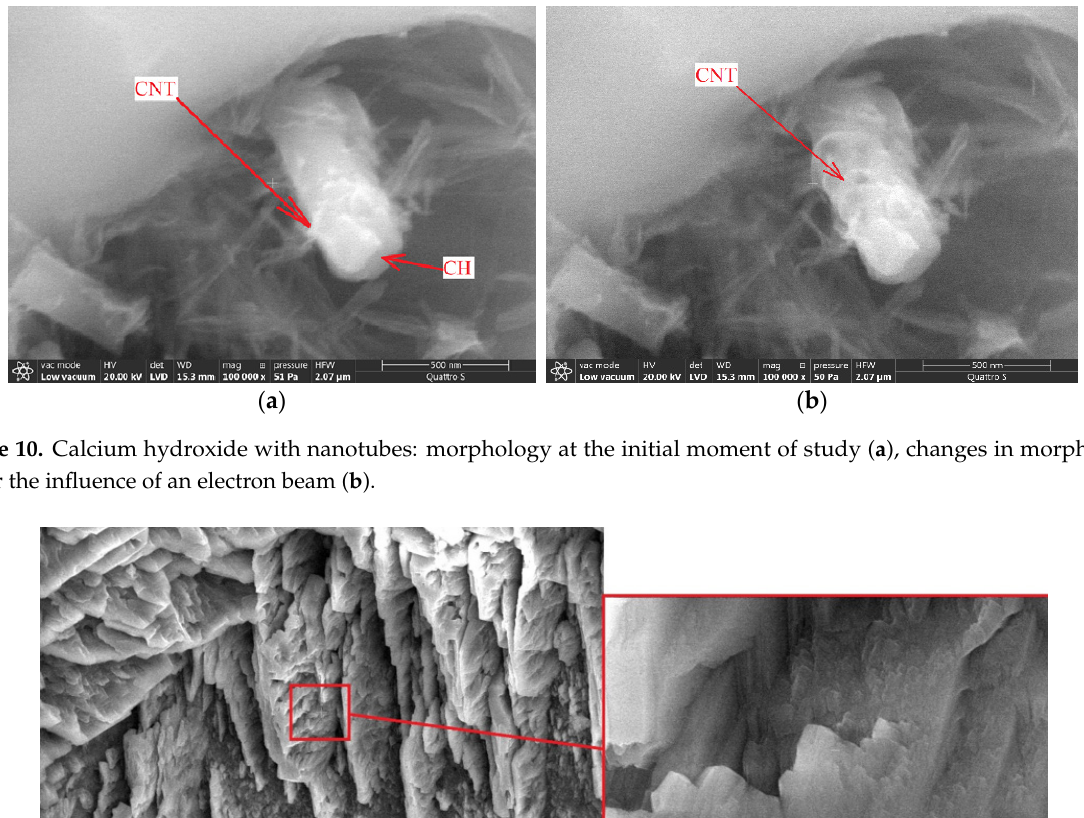
Figure 10. Calcium hydroxide with nanotubes: morphology at the initial moment of study ‐ ( a ), changes in morphology under the influence of an electron beam– ( b ).